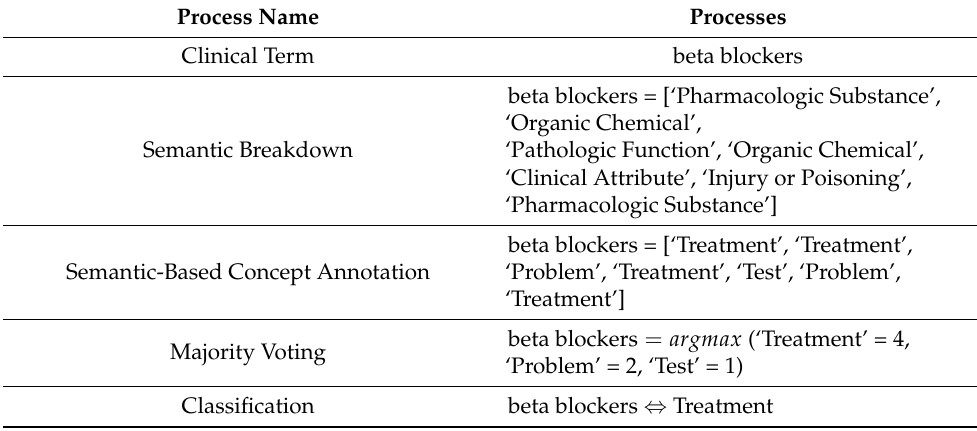
Figure 4. Appropriate threshold-value identification employs an approximate term matching ap- proach to UMLS. Table 2. The implementation scenario of Rule